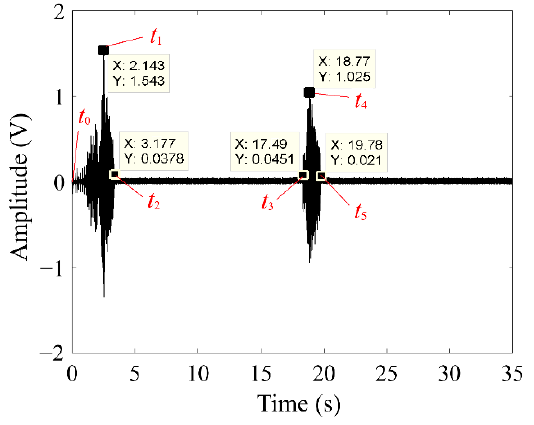
Figure 15. AE signals acquired during the clearance control process based on two-way NiTi SMA